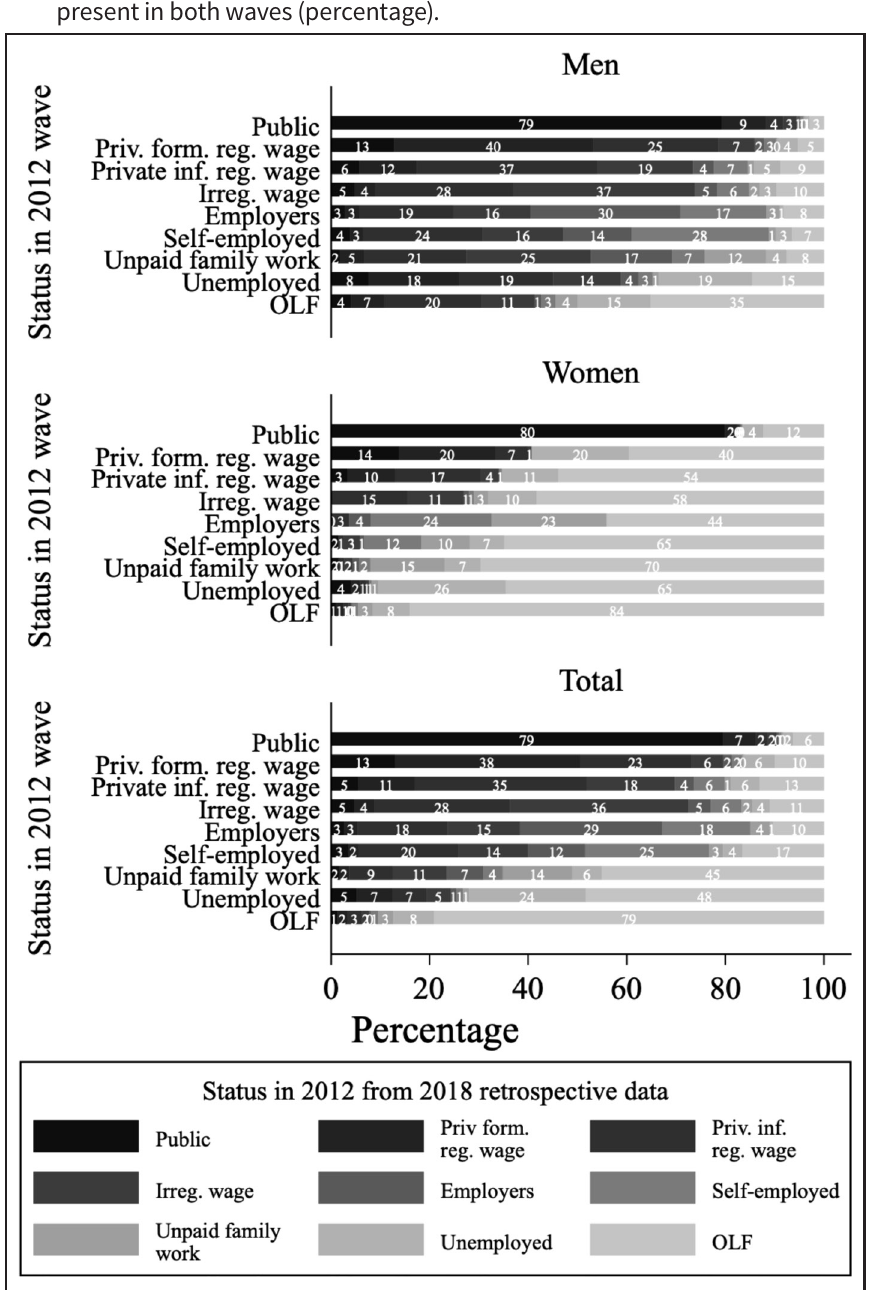
Labor market status, as reported retrospectively for 2012 from 2018 data, by sex and contemporaneous status for 2012, individuals aged 20–44 years in 2012 and present in both waves